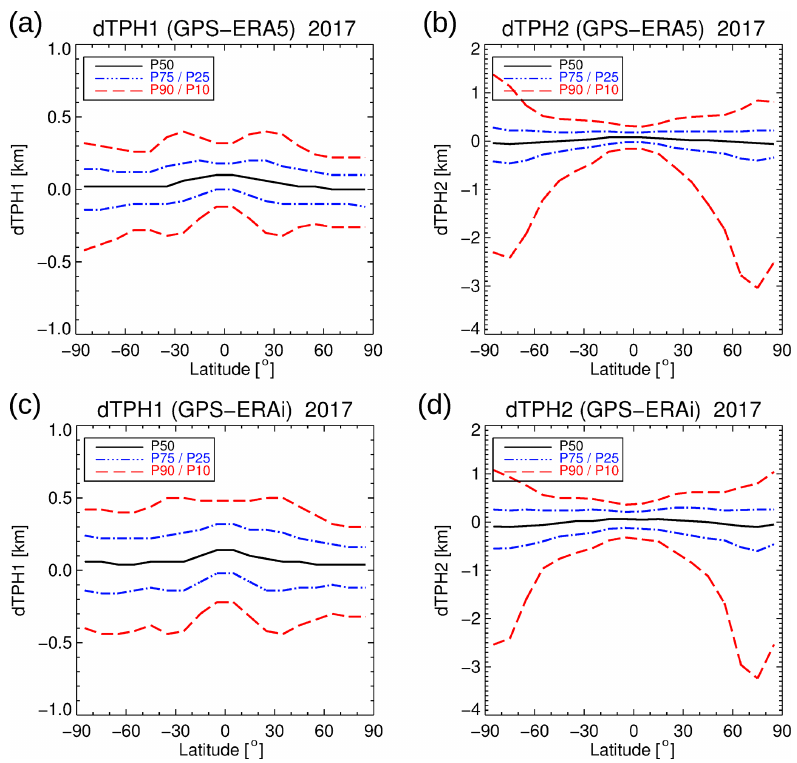
Figure 20. Zonal percentiles P 10 , P 25 , P 50 (median), P 75 , and P 90 of tropopause height differences in 2017 between GPS and ERA5 (a, b) and ERA-Interim (c, d) , respectively, with delta tropopause height (dTPH 1 ) for the first (a, c) and dTPH 2 for the second (b, d) lapse rate tropopause following the WMO criterion. The same axis ranges as in Fig. 18 are used for dTPH 1 and dTPH 2